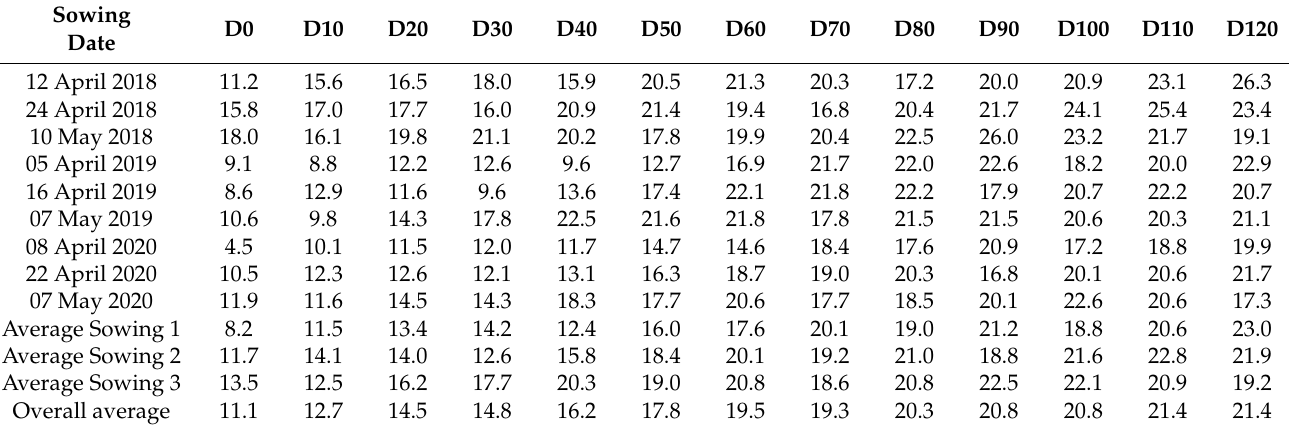
Table 5. 10-day temperature averages in ◦ C for individual sowing